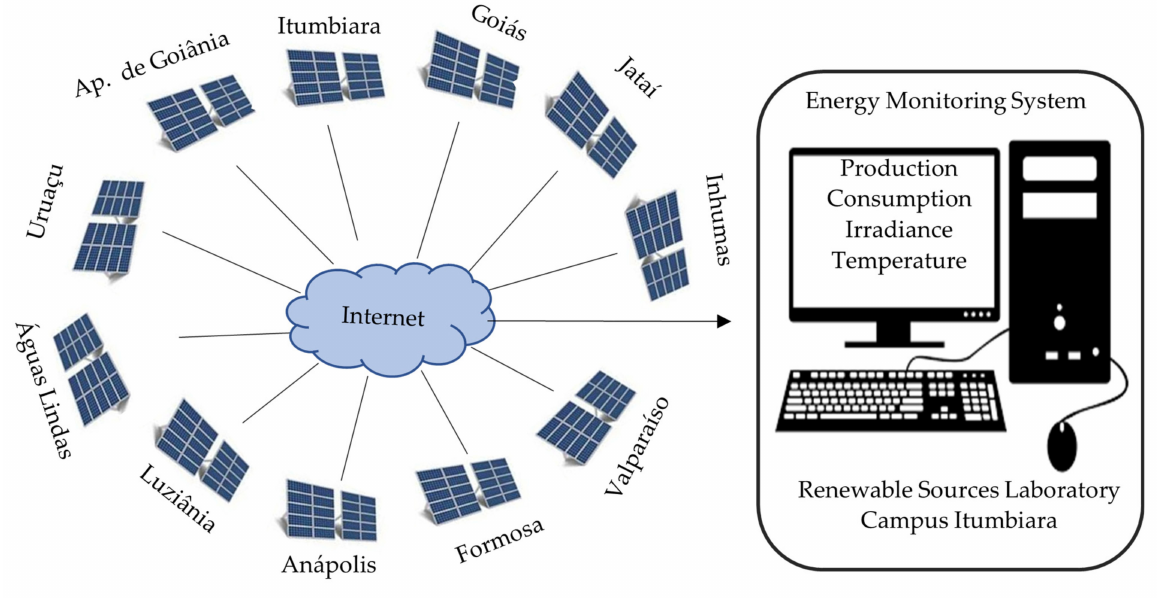
Figure 6. Energy Monitoring